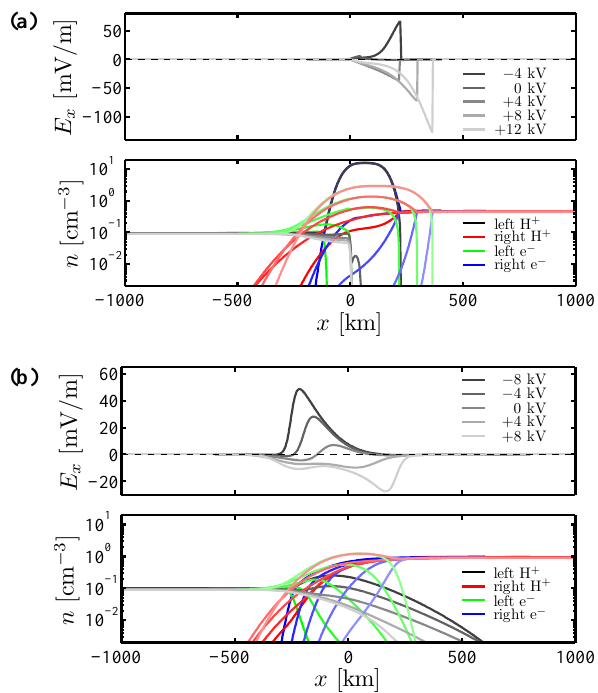
Fig. 4. Structure of a tangential discontinuity for (a) a cold–hot plasma interface and (b) a hot–hot plasma interface; the properties of the cold and hot plasmas are the same as in Fig. 3. The top panels show the electric field profile and the bottom panels plot the den- sities of the four plasma populations involved. The dimensionless transition lengths are ‘ + = 1 and ‘ − = 40. The solutions are shown for various values of the external electric potential difference and in the absence of flow